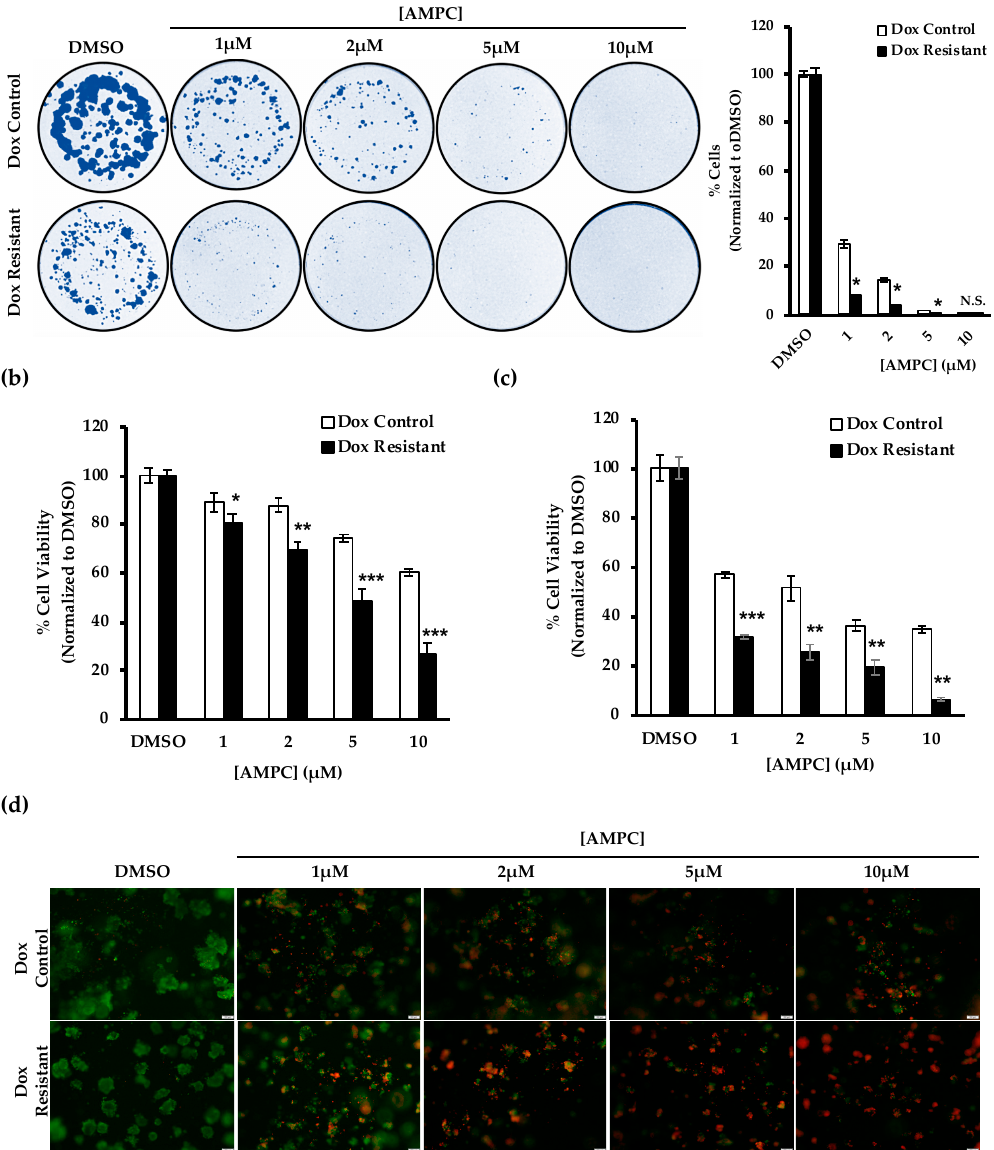
Figure 6. Doxorubicin resistant ER + MC cells exhibit enhanced sensitivity to AMPC. Control and doxorubicin resistant ER + MC cells were treated with indicated doses of AMPC ( a ) in monolayer culture at low cell density until foci formation; ( b ) for 3 days in monolayer culture; ( c – d ) for 9 days after 5 days pre-culture in medium containing 5% FBS and 4% Matrigel and subsequently stained with LIVE / DEAD cell viability assay and visualized using florescence microscopy. Red indicates dead cells and green indicates live cells. Cell viability was quantified using the AlamarBlue cell viability assay. Staining intensity of foci formation was quantified by ImageJ. The scale bar represents 200 µ m. Bar charts show means ± standard deviations. * P < 0.05, ** P < 0.01 and *** P < 0.001 (Student’s t-test).